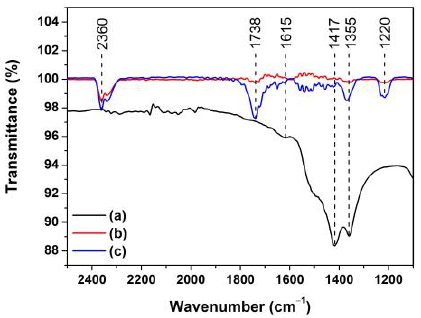
Figure 12. FTIR spectra of ( a ) initial MB solution; and MB solution after photocatalytic degradation for 150 min using ( b ) ZnO and ( c ) Ti-ZnO photocatalysts.